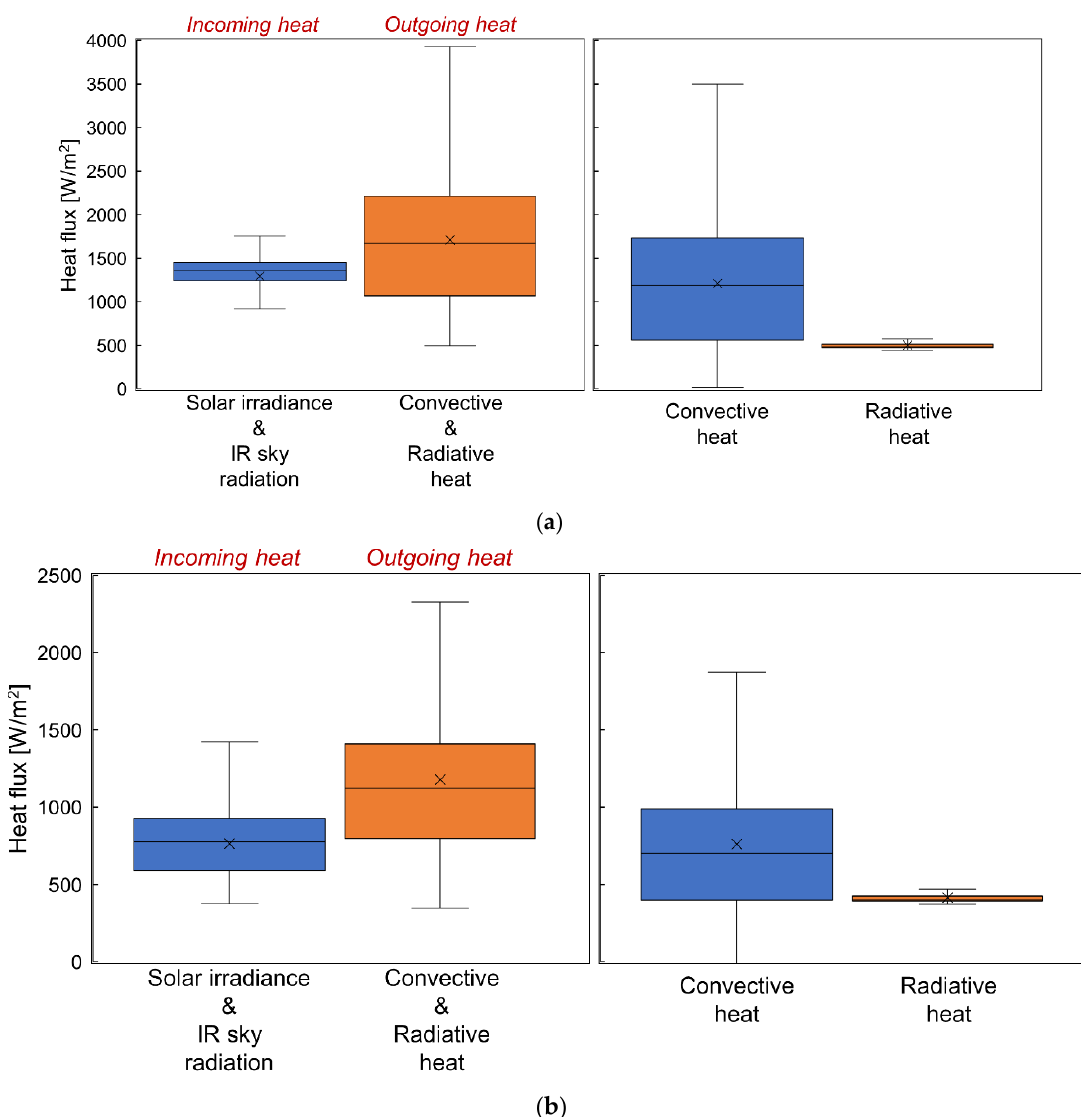
Figure 13. Heat budget of the VIPV module: ( a ) small van and ( b ) sedan.